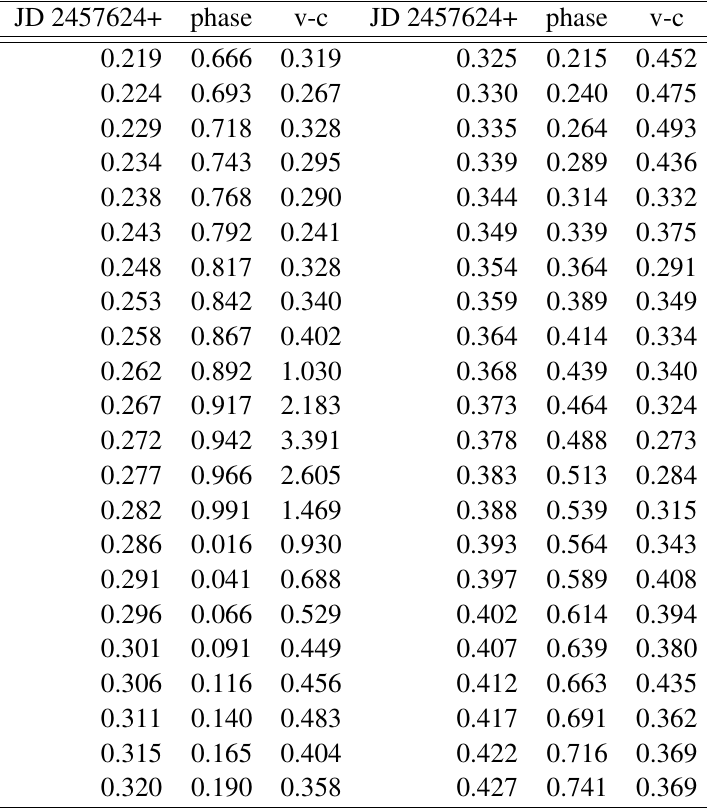
Table 4 list of CCD Photometry of DQ Her in V filter.